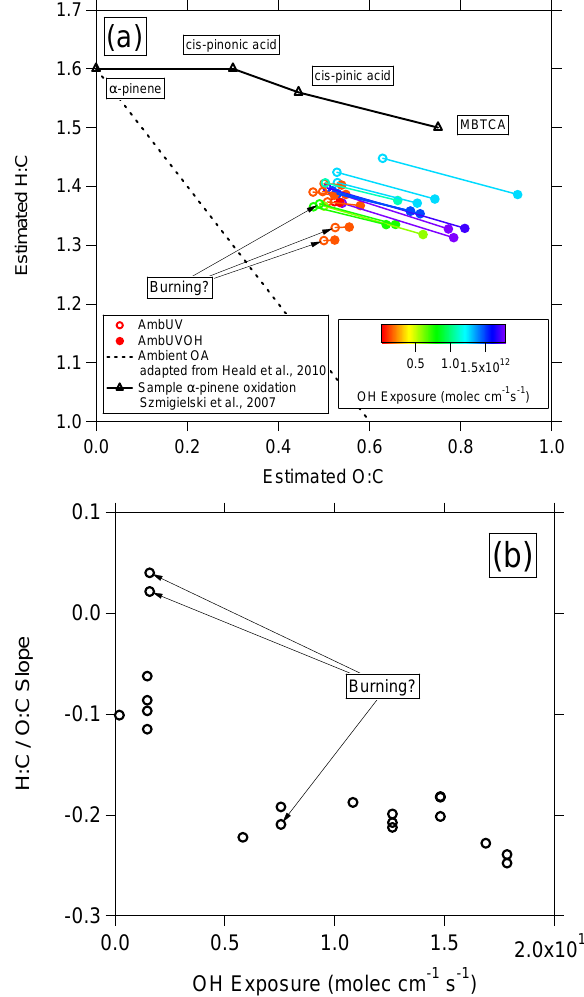
Fig. 7. (a) Estimated Van Krevelen plot for AmbUV and AmbU- VOH conditions, colored by OH exposure. H:C and O:C ratios are estimated from the SOA parameterization of Ng et al. (2011). Dashed line has a slope of − 1, which was observed in ambient OA by Heald et al. (2010), but begins at begins at H:C=1.6, O:C=0 to reflect the probable dominance of terpene precursors. An example of an α -pinene oxidation pathway is also shown (Szmigielski et al., 2007). (b) Van Krevelen slopes from Fig. 7a as a function of OH